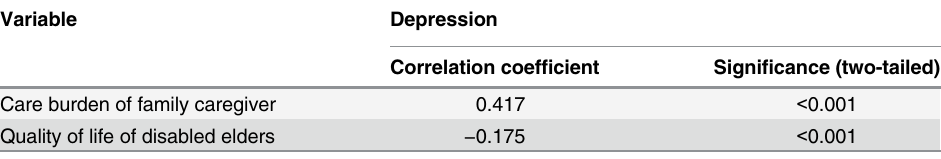
Table 4. Correlation with Spearman ’ s rho between the depressive emotion and the care burden of informal caregivers and the quality of life of disabled elders (N = 444).